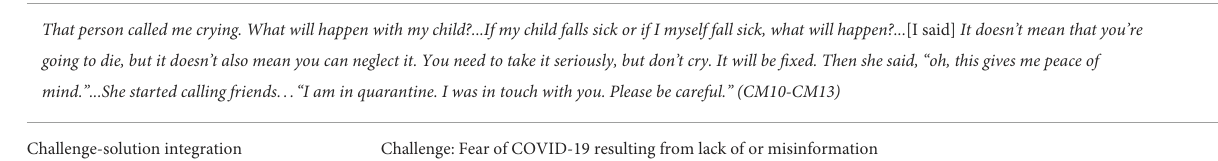
TABLE 2 Individual/community/system level challenges and problem-solution connection strategies with embedded NRC-RIM toolkit and promising practice starting points for public health jurisdictions focused on building capacity. Individual challenge &